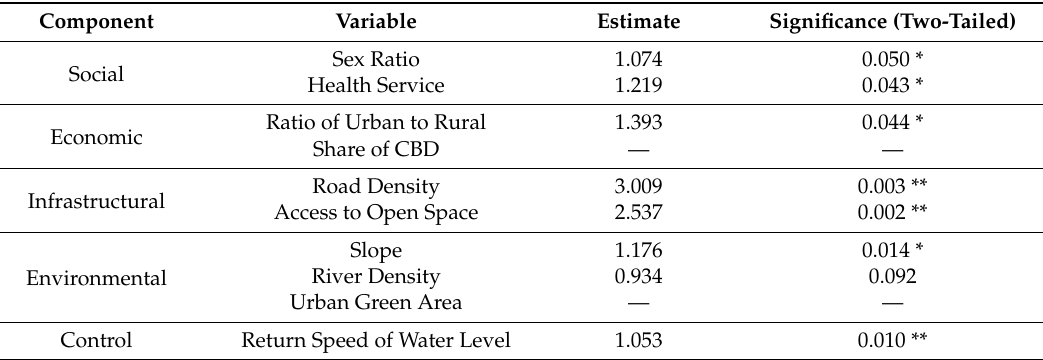
Table 5. Regression results of potential variables.